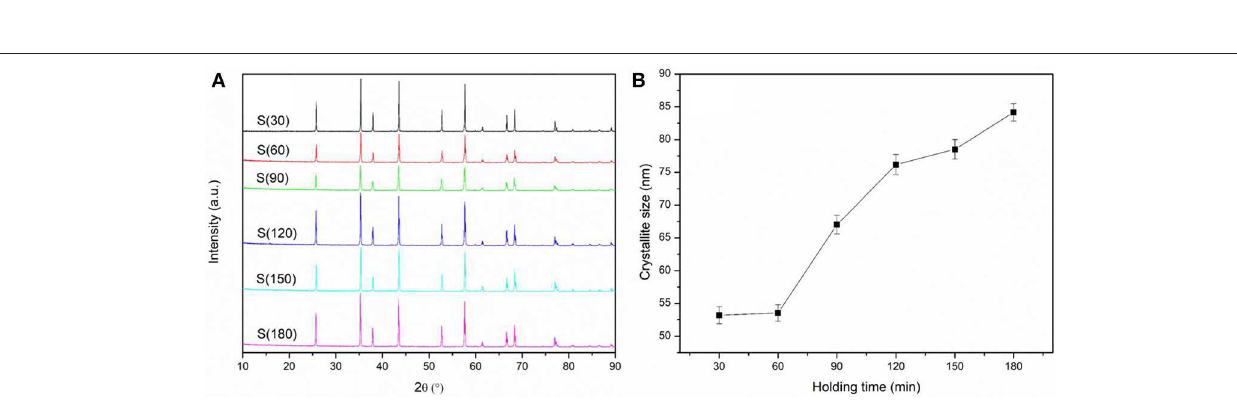
Frontiers in Materials |